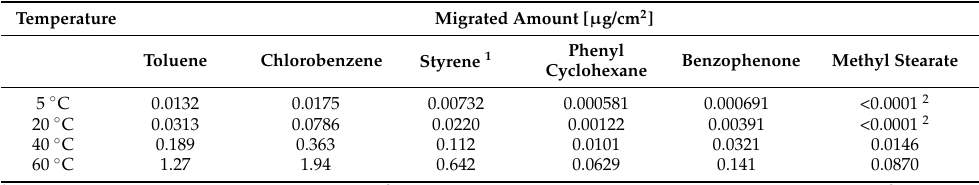
Table 1. Experimentally determined migrated amount into the gas phase from HIPS after storage for 10 days at 5 ◦ C, 20 ◦ C, 40 ◦ C and 60 ◦ C.